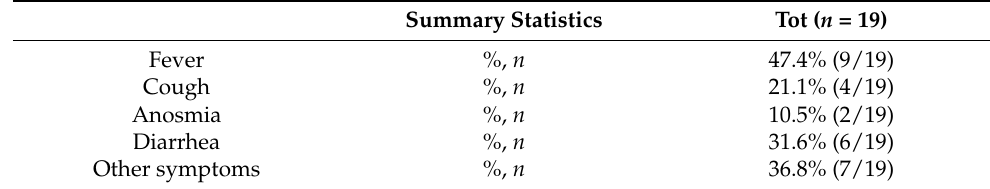
Table 2. COVID-19 related symptoms during